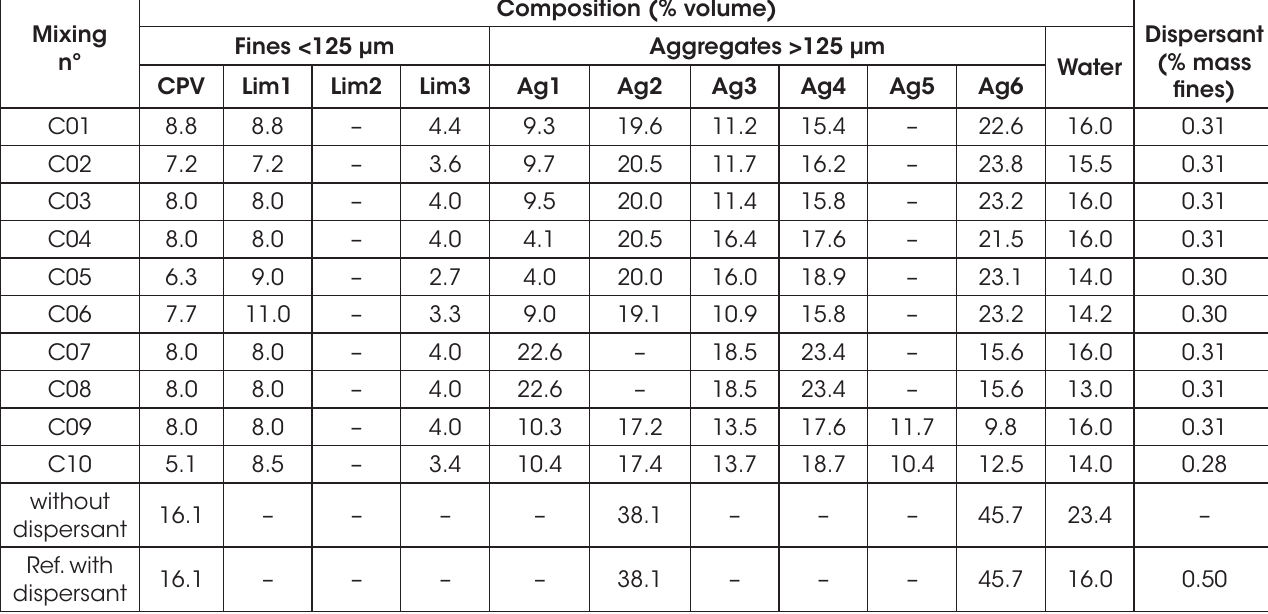
Concretes designed by packing technology